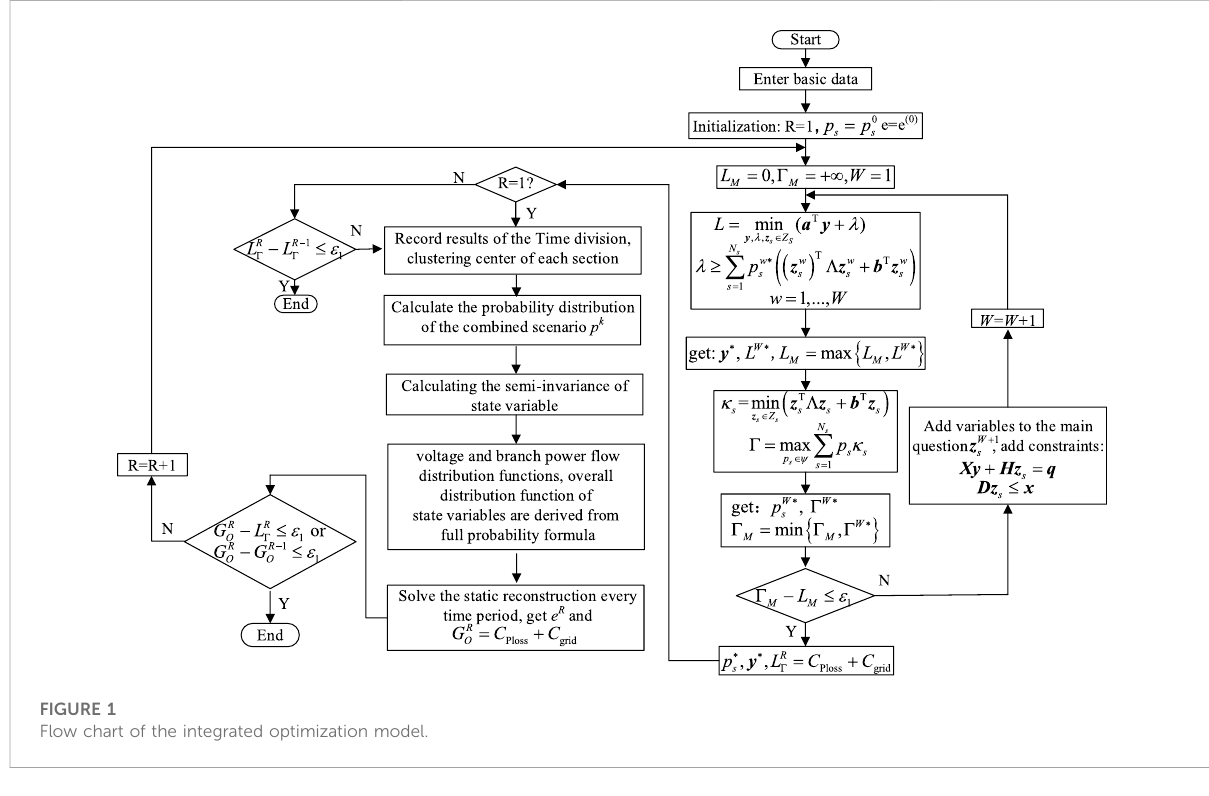
FIGURE 1 Flow chart of the integrated optimization model.